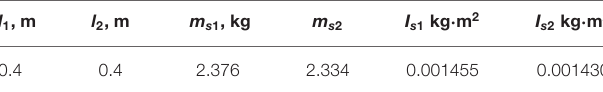
TABLE 3 | Parameters of the experimental manipulator with air